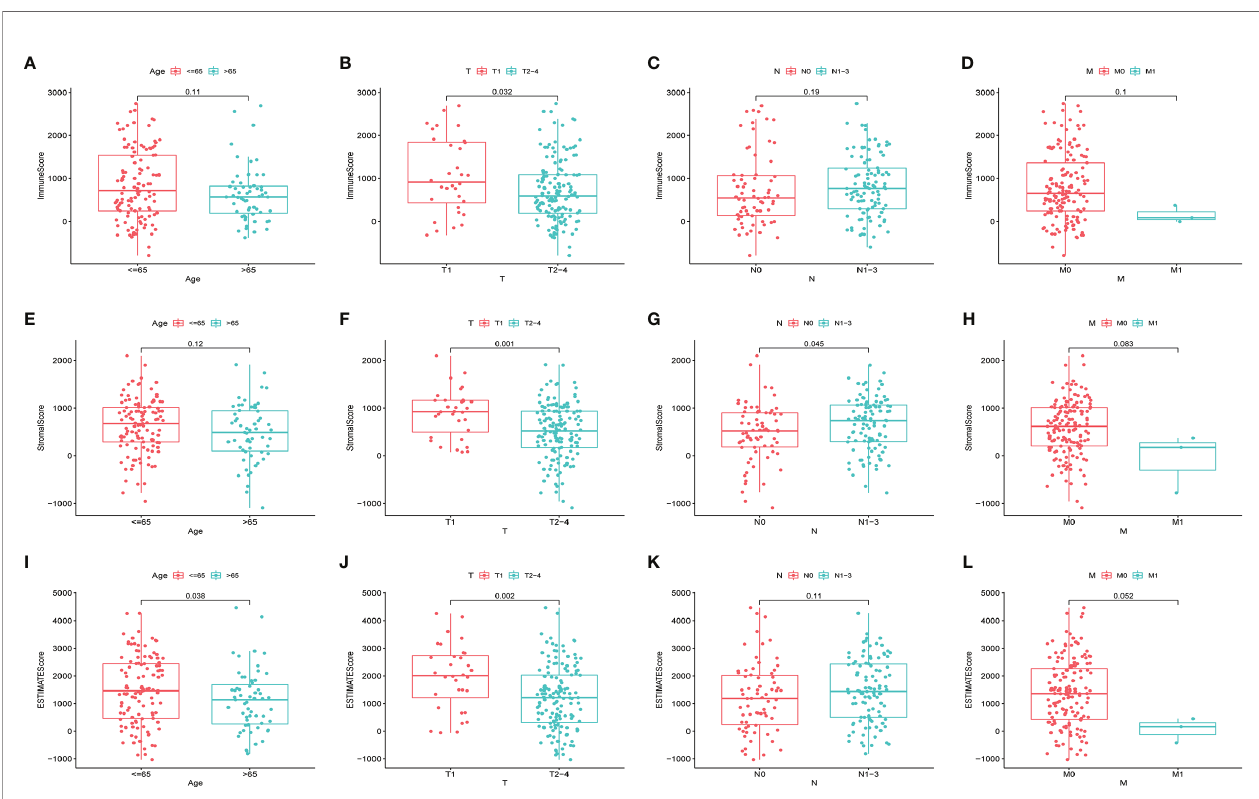
FIGURE 2 | Associations of ImmuneScore, StromalScore, and ESTIMATEScore with age or TNM staging in HER2+ BC patients. Kruskal – Wallis rank sum tests of the associations of (A – D) TME immune components, (E – H) TME stromal components, and (I – L) TME immune and stromal components with age or TNM